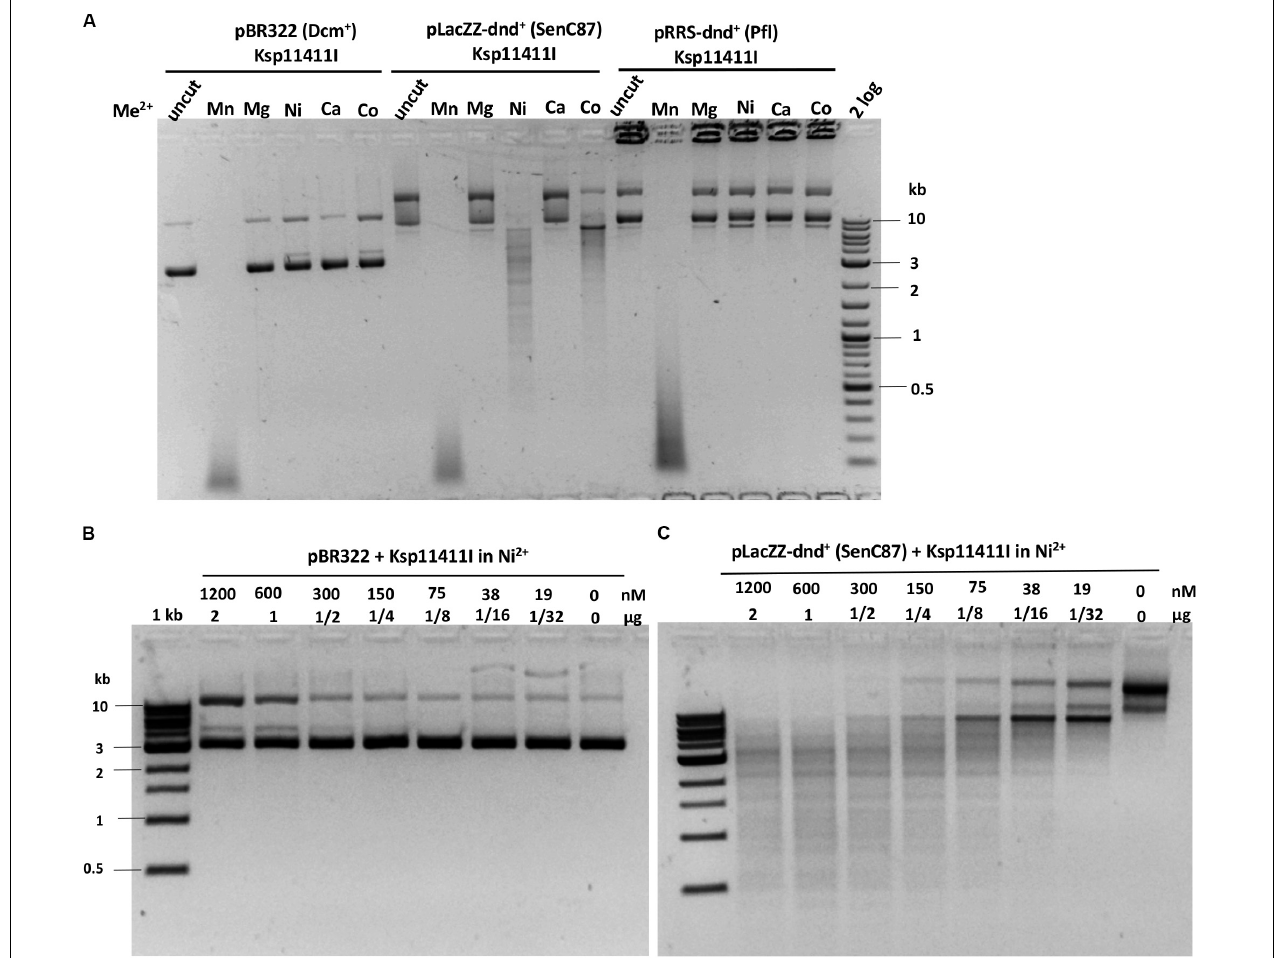
FIGURE 5 | Ksp11411I divalent cation requirement and activity in Ni 2 + buffer on methylated and phosphorothioated plasmids. (A) Ksp11411I mediated digestion of pBR322 (Dcm + ), dnd + (SenC87) and dnd + (Pfl) plasmid in medium salt buffer supplemented with different divalent cations. (B) Ksp11411I digestion of pBR322 (Dcm + ) in Ni 2 + buffer (0.1 mM Ni 2 + ). (C) Ksp11411I digestion of dnd + plasmid (SenC87) in the same buffer as in (B) . The relative selectivity for dnd + plasmid (SenC87) over pBR322 was estimated at 8 to